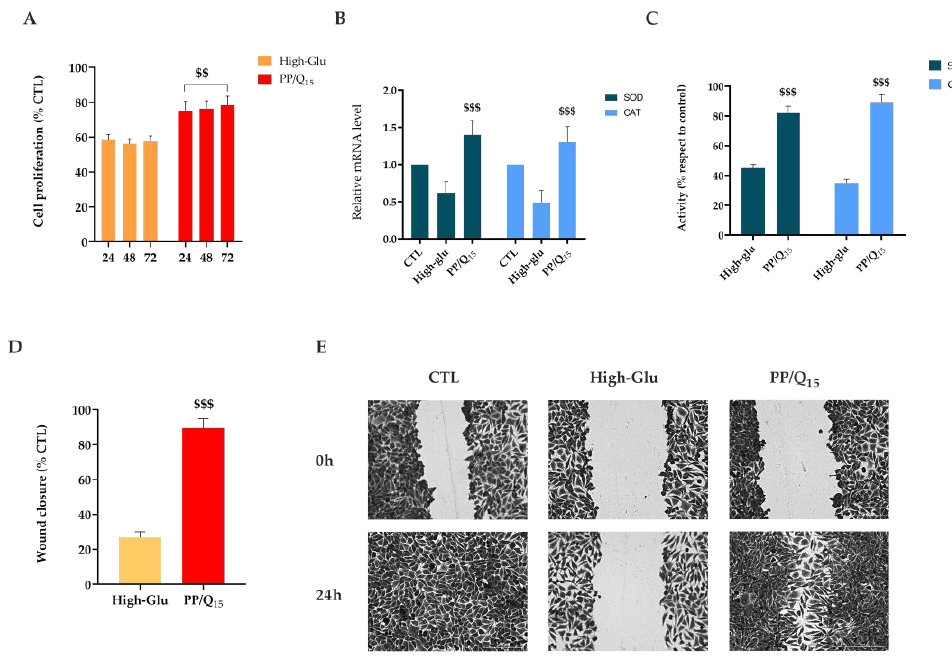
Figure 6. Effect of PP/Q 15 membrane on fibroblasts migration, anti-oxidative genes expression and activities under hyperglicaemic conditions. ( A ) HDF proliferation after 24, 48, and 72 h in the pres- ence of high glucose concentration (25 mM, high-glu) alone or with PP/Q 15 membrane. ( B ) mRNA transcription level and ( C ) activities of Superoxide dismutase ( SOD ) and catalase ( CAT ) under hy- perglicaemic conditions. ( D ) Quantitative analysis and ( E ). Representative images of wound closure at 0 and 24 h after treatment high concentration of glucose (25 mM, high-glu) alone or with PP/Q 15 membrane. Scale bars are 50 μm. (n = 3). Results are expressed as the mean of three independent experiments ± S.D (n = 3). Statistically significant variations $$ p < 0.01 and $$$ p < 0.001 versus high- glu.